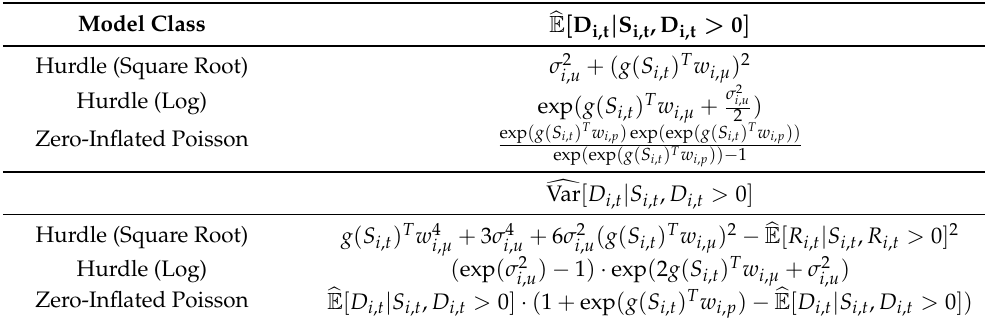
Table A2. Definitions of (cid:98) E [ D i , t | S i , t , D i , t > 0 ] and (cid:100) Var [ D i , t | S i , t , D i , t > 0 ] for each model class.